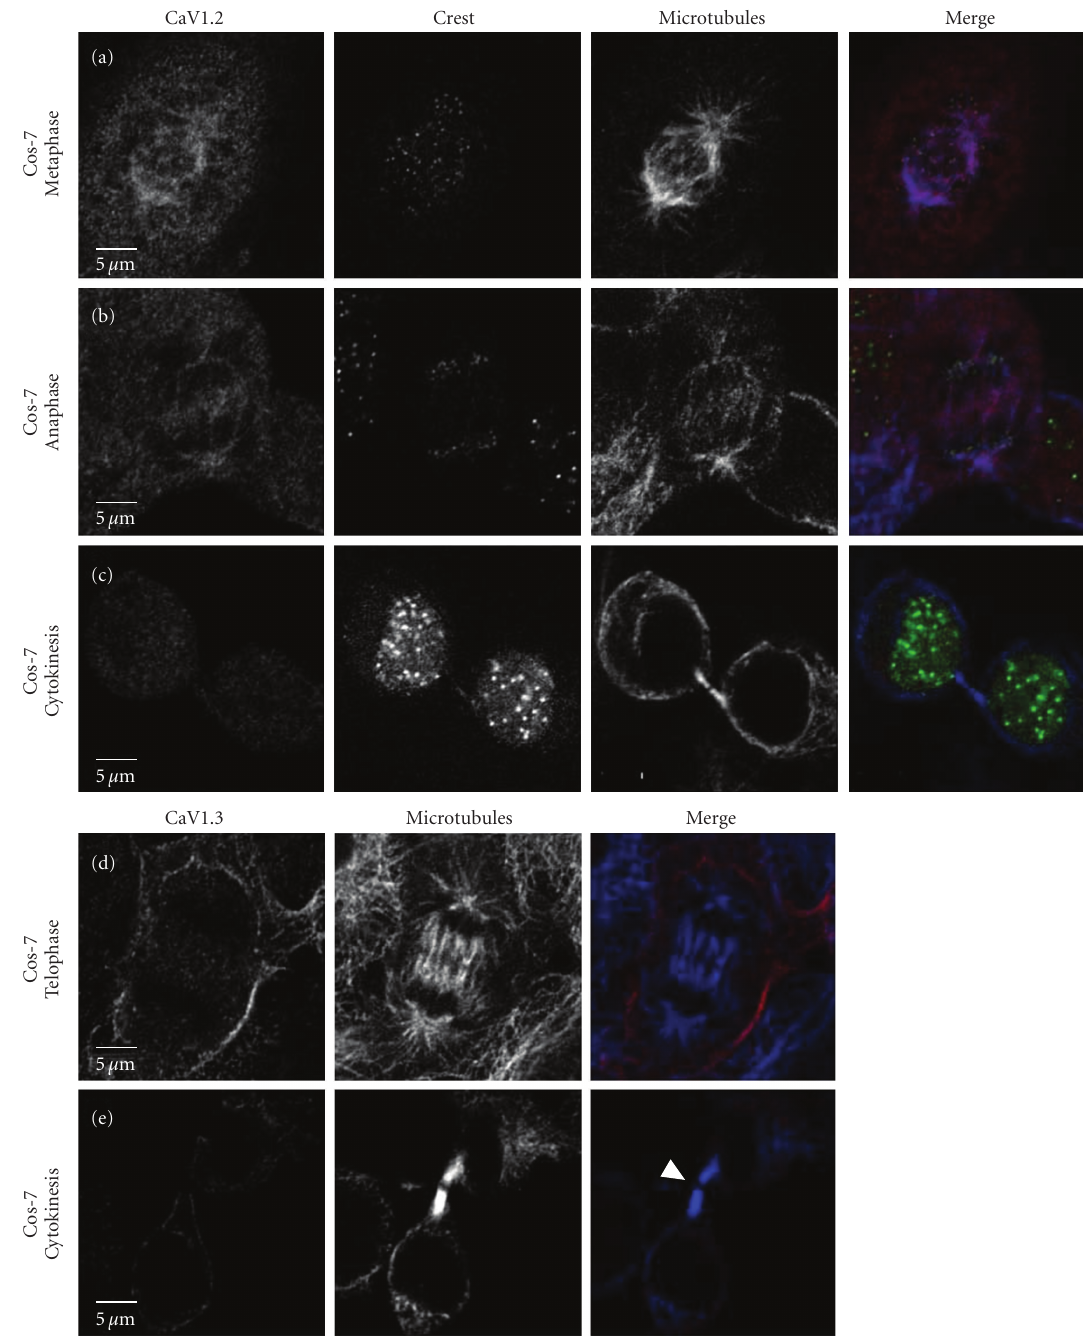
Figure 1: Calcium channel CaV1.2 and CaV1.3 localization in mitotic cells . 1(A) compares CaV1.2 staining in AtT-20 cells (a)–(c), PC-12 cells (d), and INS-1 cells (e)–(g). CaV1.2 is located with kinetechores at the “poleward side” during metaphase and anaphase ((a), (b): inset) in the AtT-20 cells. Midbody CaV1.2 staining is observed in both AtT-20 cells and PC-12 cells (c), (d) but not in INS-1 cells (g). 1(B) is a similar comparison for CaV1.3 and shows staining at the mid-spindle zone only in AtT-20s during telophase (a). In contrast, all three neuroendocrine cell types display CaV1.3 staining at the midbody during cytokinesis ((B): (b), (c), and (e)). 1(C) shows control staining of Cos 7 cells; in particular, note that there is no nonspecific staining at the midbody of these cells (1(C) (c), (e)). CaV1.2 and CaV1.3 are stained with antibodies specific to alpha subunit sequences for CaV1.2 and CaV1.3 (see Methods, Alamone Labs) and detected with secondary goat anti-rabbit antibody Alexa 555 (red); Microtubules are stained with DM1A and goat anti-mouse Alexa 647 (blue); kinetechores are stained with anti-CREST antibody and Alexa 488 (green). Bleedthrough between microtubule and CREST staining channels was corrected for as described in